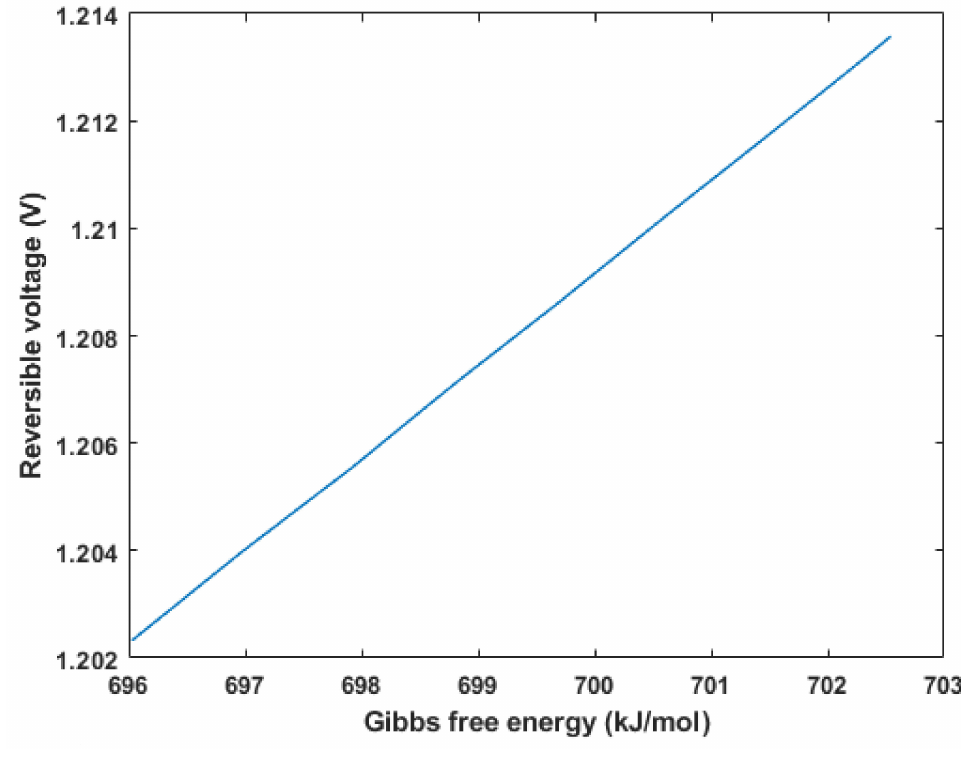
Figure 10. Reversible voltage vs. Gibbs free energy.